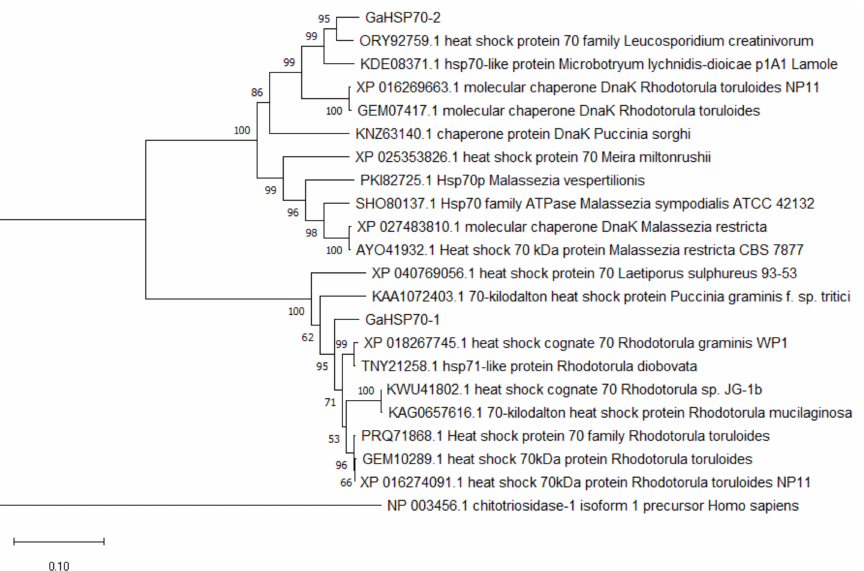
Figure 1. Phylogenetic tree analysis of GaHSP70-1 and GaHSP70-2 aligned with HSP70 proteins from other organisms. A chitotriosidase from Homo sapiens was used as an outlier. The tree was constructed using the neighbor-joining method. The numbers close to the individual branches represent the percentage of the 1000 bootstrap iterations supporting the